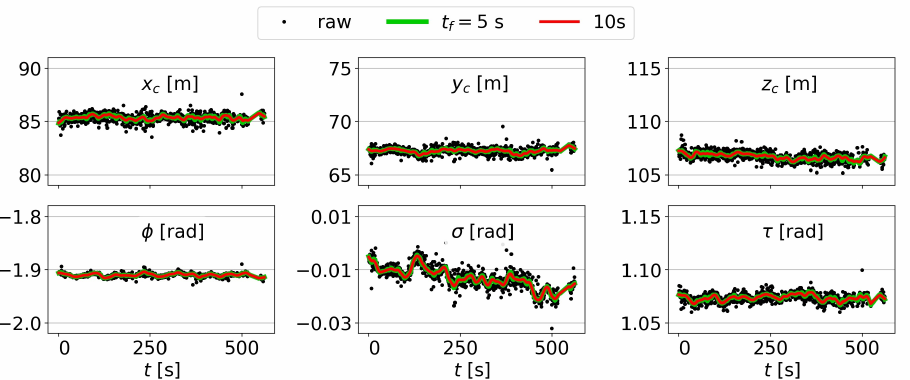
Figure 8. Extrinsic parameters obtained for video 1 (black dots), as well as interpolated and filtered results for filtering times of t f = 5 s and t f = 10